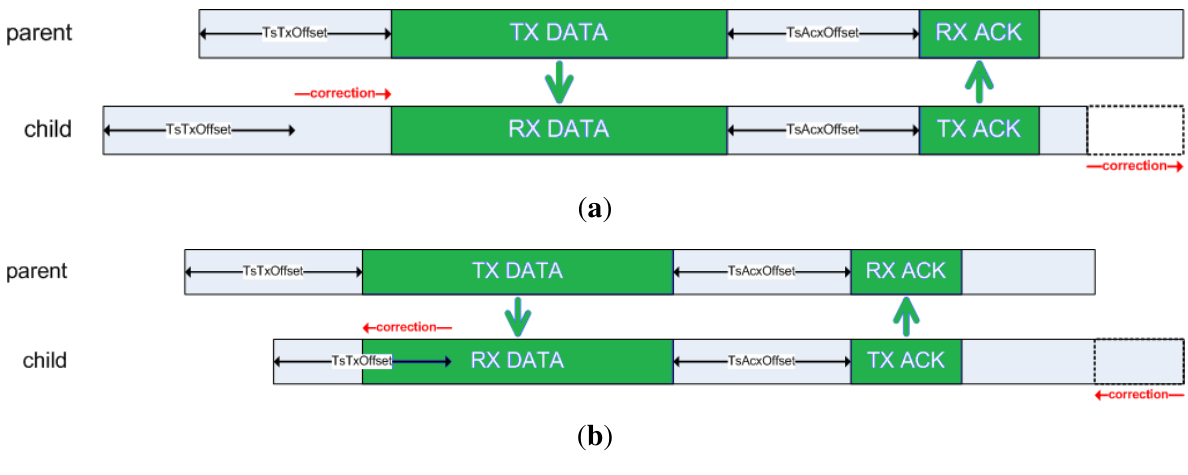
Figure 3. Packet synchronization diagram: ( a ) Packet synchronization: enlarging the time slot. ( b ) Packet synchronization: shortening the time slot.